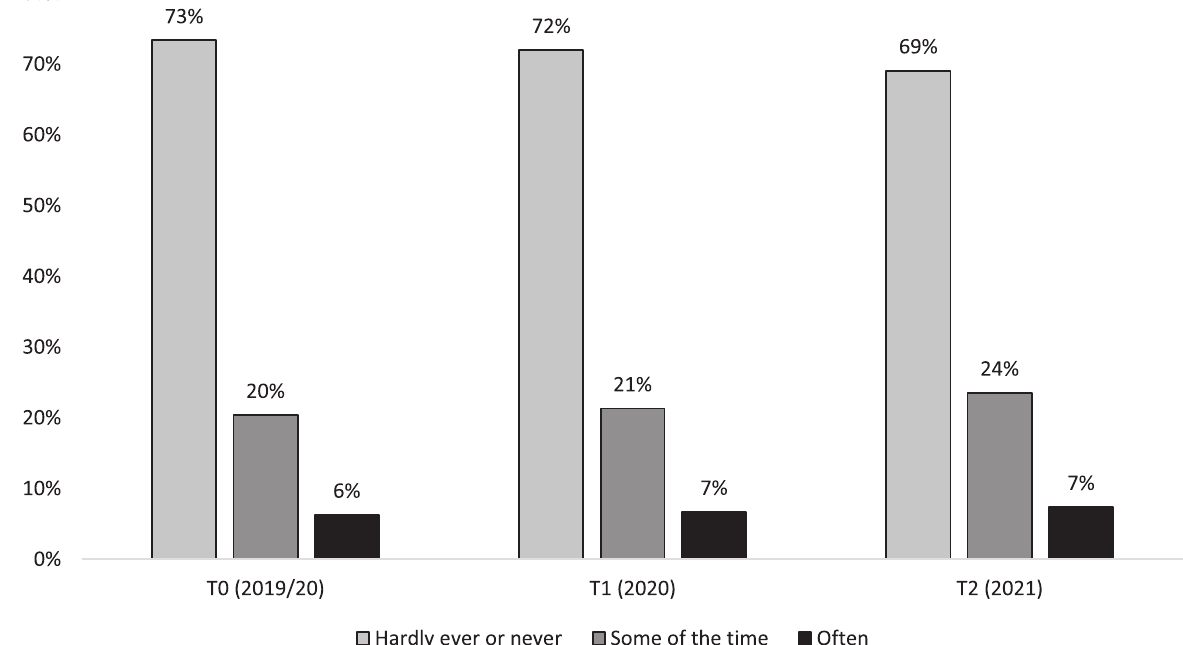
Figure 1. Feelings of loneliness before and during the pandemic. Note: N = 85,344 observations (28,448 respondents). Source: Based on SHARE waves 8 and 9, release